Question: In a single sentence, describe what this figure presents.
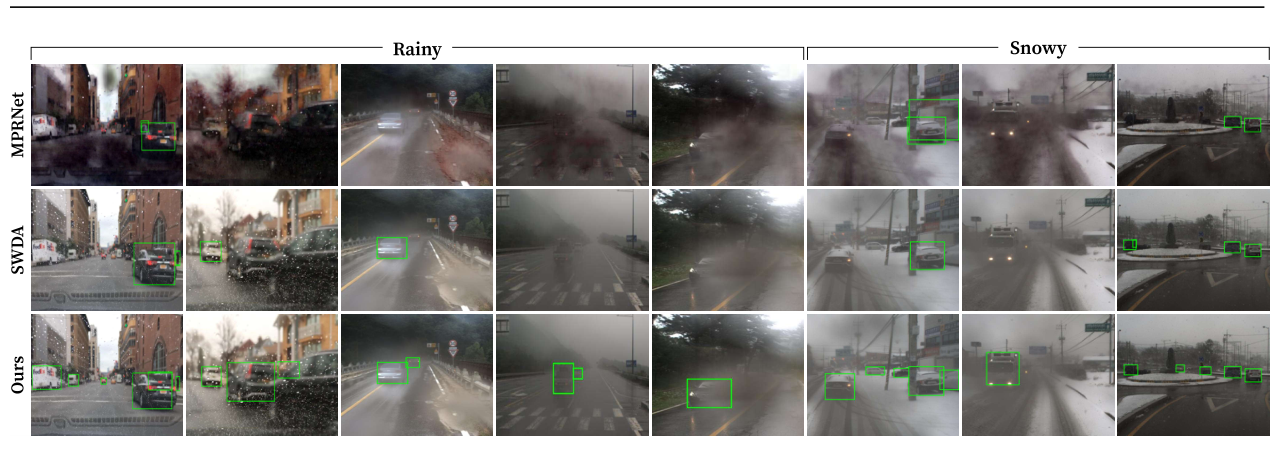
Answer: Qualitative results on real-world target datasets. Compared to other methods, Ours successfully detects the objects even in the presence of severe weather corruption and style variations. Even though MPRNet removes raindrops in the first two images, the detector performance remains low, indicating images generated by the removal network do not consistently help object detection. In the remaining images, the removal network fails to remove corruptions and instead creates some artifacts due to the disparity between real weather data and synthetic weather data, which MPRNet was trained on. While SWDA directly adapts the network to the target domain, it fails to detect objects under severe weather corruption and environmental differences. More qualitative results are available in our multimedia material.